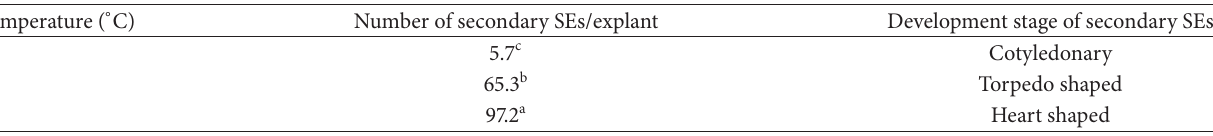
Table 2: Effect of temperature on production of secondary SEs from germinated SEs of H. dulcis after 6-week culture on MS agar medium without plant growth regulators X